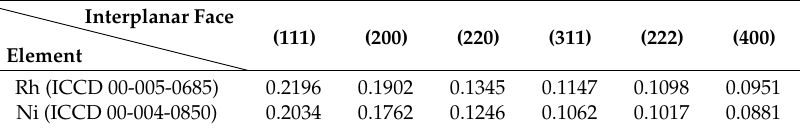
Table 2. Lattice spacing (nm) and indexed reflection planes of Rh 70 Ni 30 BNPs determined by HRTEM in Figure 4.